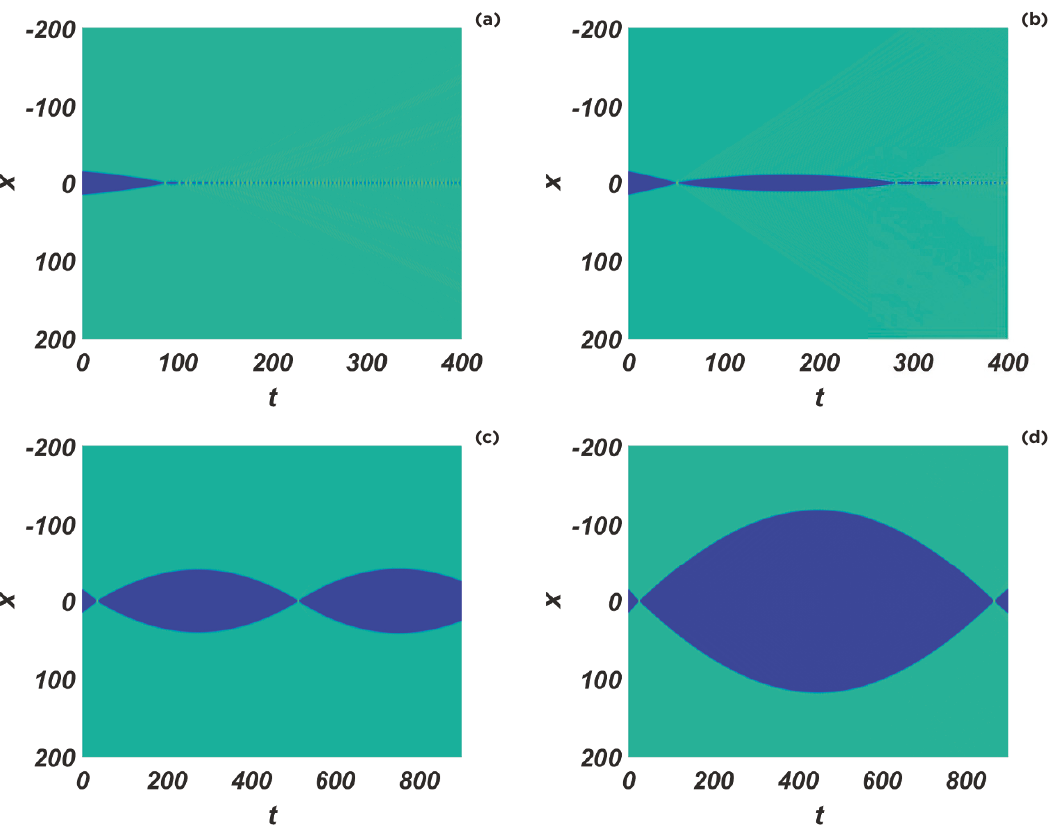
Figure 5 . False vacuum in a bounded interval: antikink-kink collision for (cid:15) = 0 : 001 and with (a) v = 0 : 1 (upper left), (b) v = 0 : 25 (uper right), (c) v = 0 : 4 (lower left), (d) v = 0 : 6 (lower right). The (cid:12)gures show slices in the plane ( x; t ) of the scalar (cid:12)eld. Blue color represents the false vacuum (cid:30) = (cid:0) 1 and the true vacuum (cid:30) = +1 is represented in